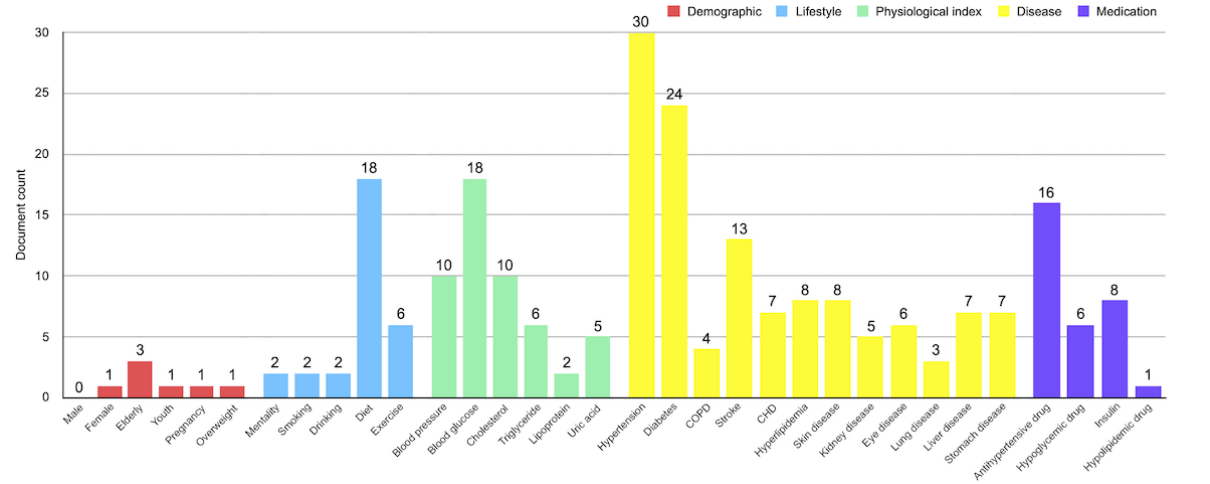
Figure 8. Topic distribution of the test